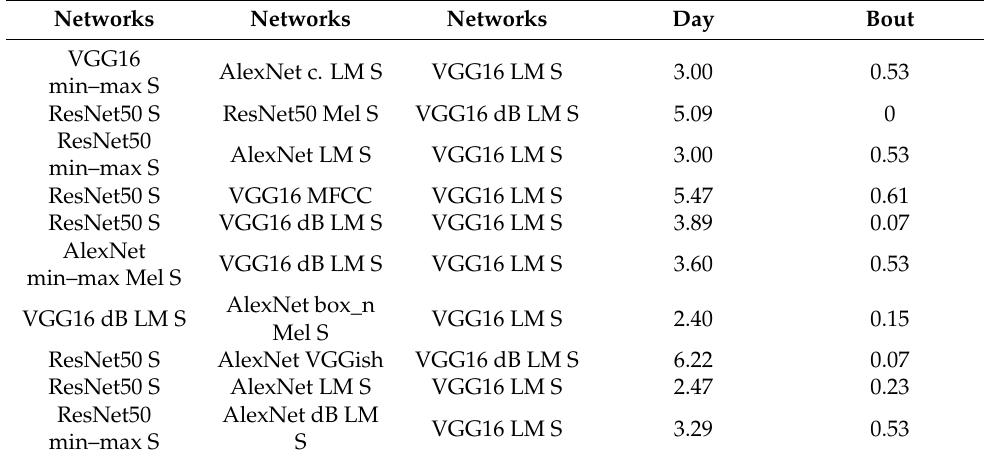
Table 6. Equal Error Rate (EER) of Best Performing 3-Ensemble on the EER Day and EER Bout Datasets (sorted by